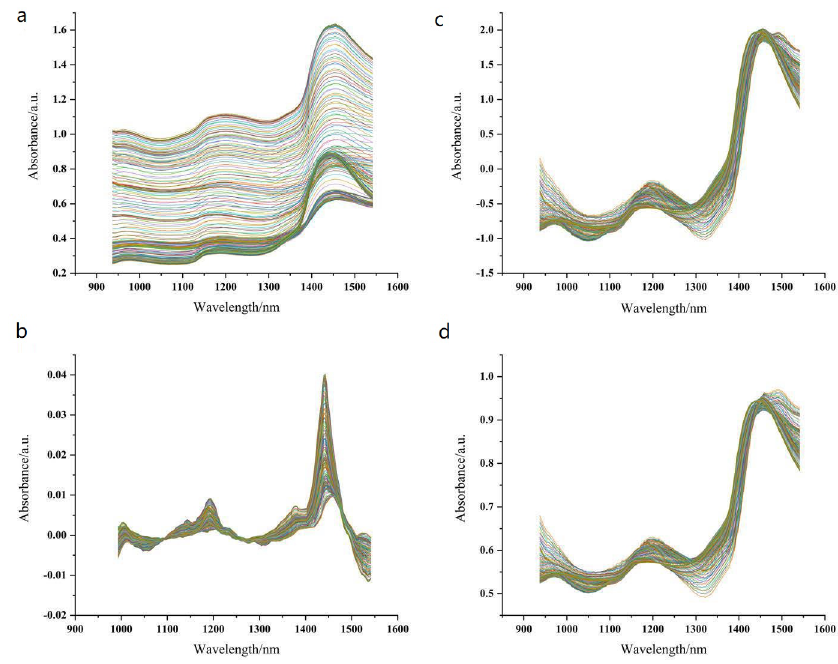
Figure 3. Spectrum of Longjing tea under different processing timings: ( a ) raw spectrum; ( b ) spectrum after SNV pretreatment; ( c ) spectrum after S-G pretreatment; ( d ) spectrum after MSC pretreatment.